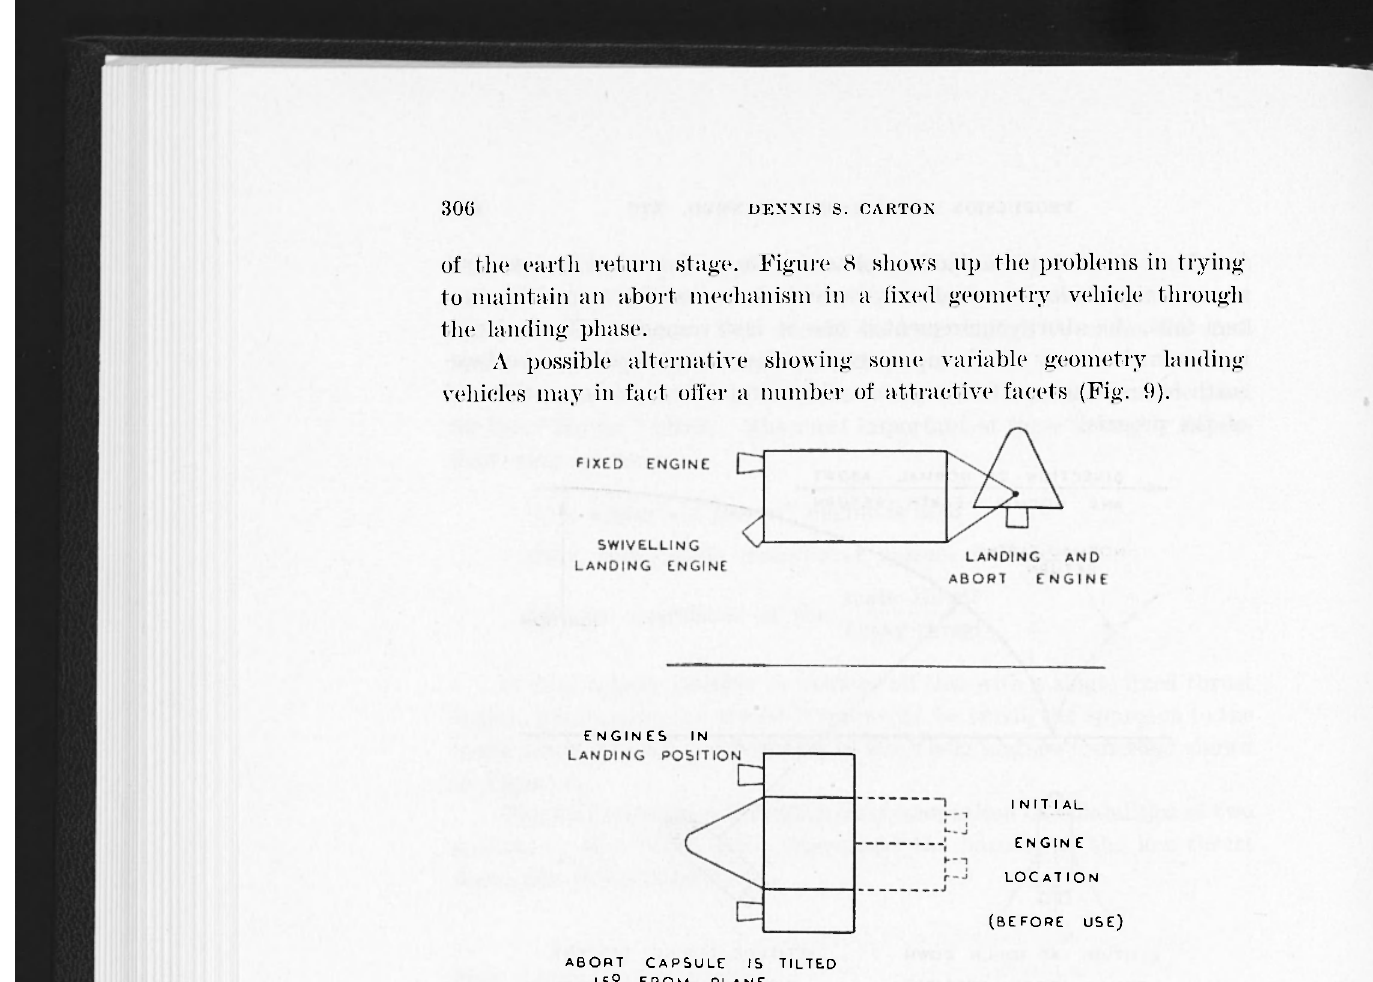
Fig. 9 - Some variable geometry manned lunar landing